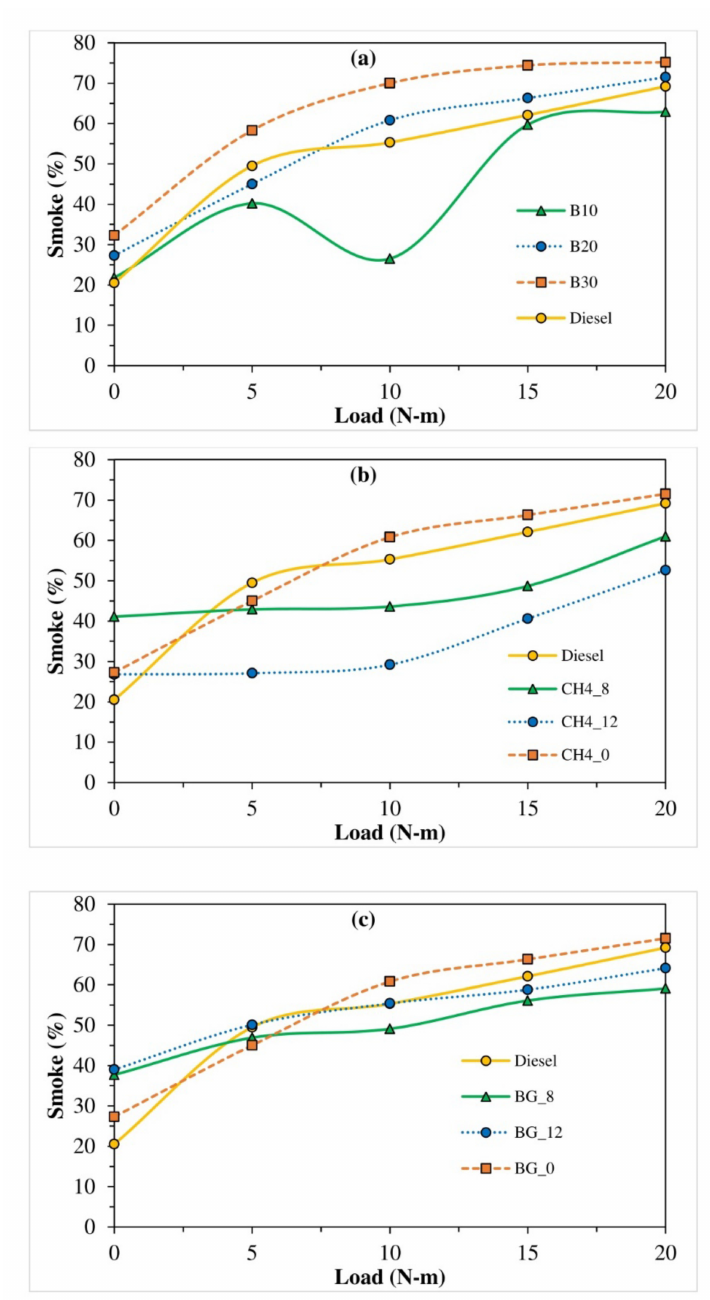
Figure 4. Variation of smoke emissions with load at various ( a ) Mahua biodiesel blend, ( b ) methane flow rate and ( c ) biogas flow